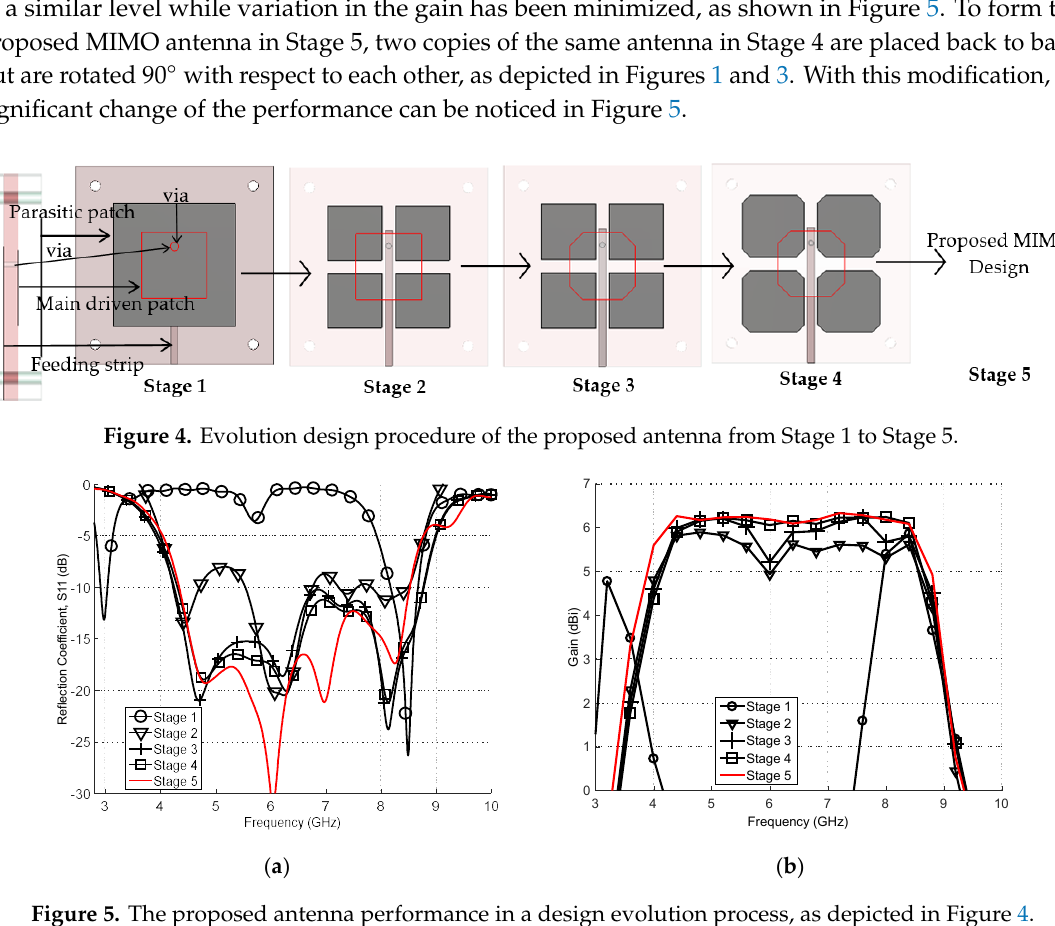
Figure 5. The proposed antenna performance in a design evolution process, as depicted in Figure 4. ( a ) Reflection coefficient (S11); ( b ) gains.